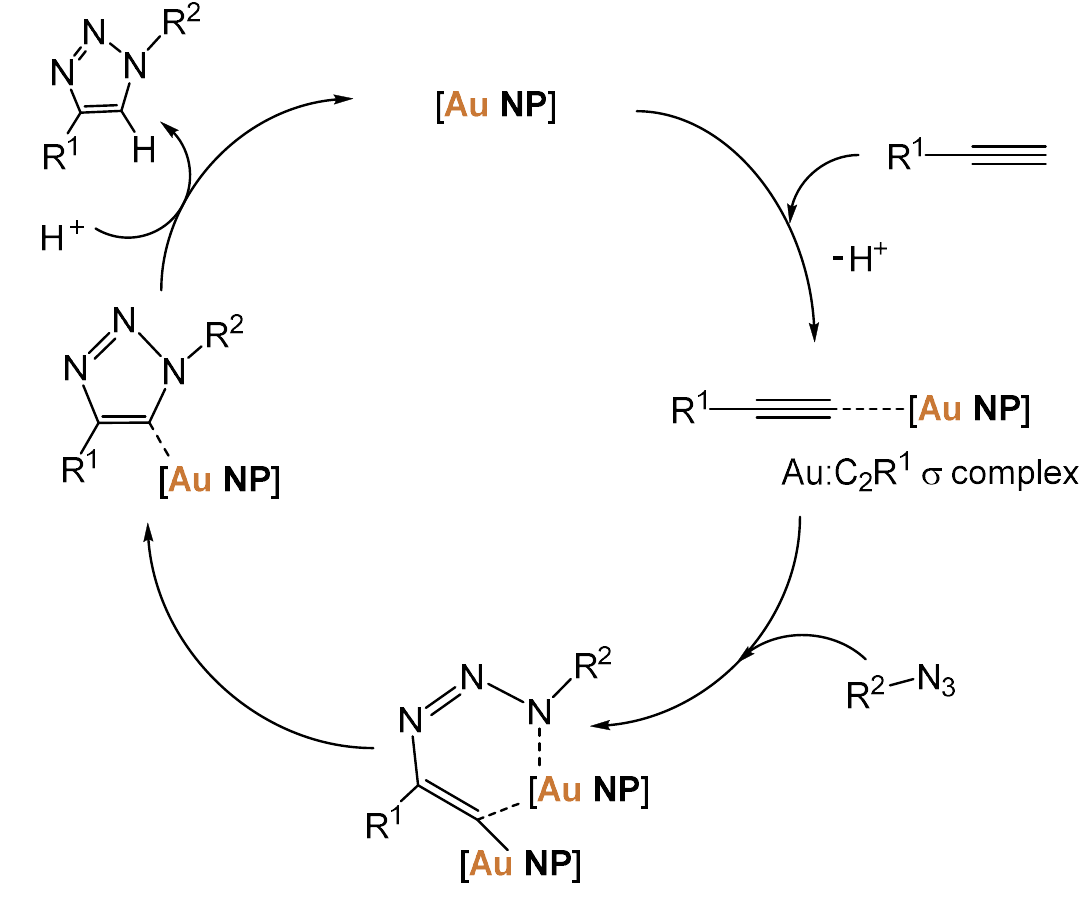
Scheme 4. Proposed mechanism for the AuAAC reaction.